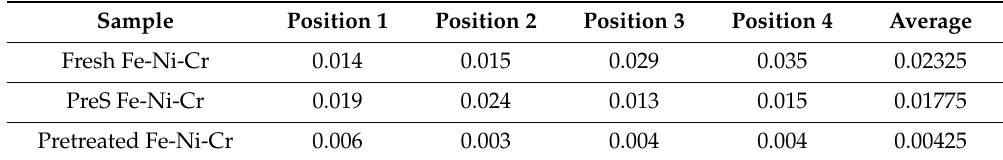
Table 5. Sulfur detection in wt% for the three Fe-Ni-Cr samples: Fe-Ni-Cr sample without sulfur addition, presulfided and pretreated before cracking without presulfiding. The error margin is 0.001 wt% for all measurements. Acceleration voltage: 15 kV.